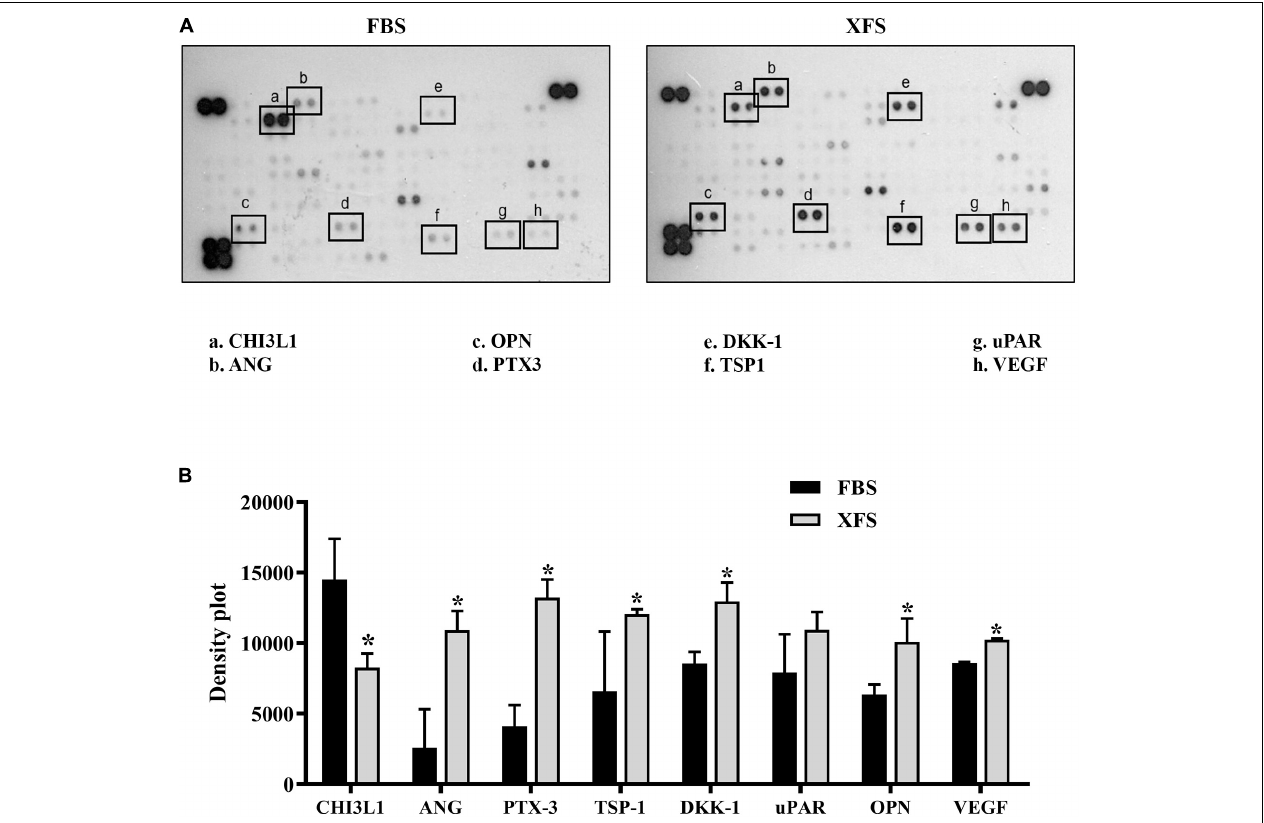
FIGURE 2 | Characterization of secretome protein profile of hBMSCs cultured in FBS- or XFS-containing medium. (A) Cytokine array membrane of hBMSCs-CM (FBS-CM and XFS-CM) representative of two independent experiments. (B) Quantification of the integrated pixel density for each identified cytokine using Fiji ImageJ. Data are shown as mean ± SD. * P < 0.05, Mann–Whitney. ANG: angiogenin; CHI3L1: chitinase-3-like-1; DKK-1: dickkopf-1 WNT signaling pathway inhibitor; NGAL: lipocalin-2; OPN: osteopontin; PTX-3: pentraxin-3; TSP-1: thrombospondin-1; uPAR: plasminogen activator, urokinase; VEGF: vascular endothelial growth factor.